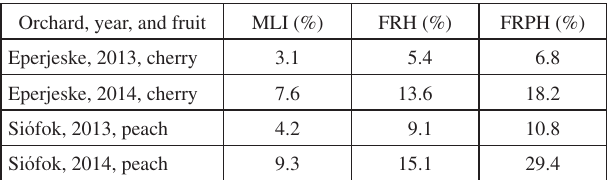
Table 1. Mean latent incidence (MLI %), fruit rot incidence at harvest (FRH, %) and fruit rot incidence at postharvest (FRPH, %) caused by Monilinia spp. in sour cherry (Eperjeske 2013 and 2014) and peach (Siófok